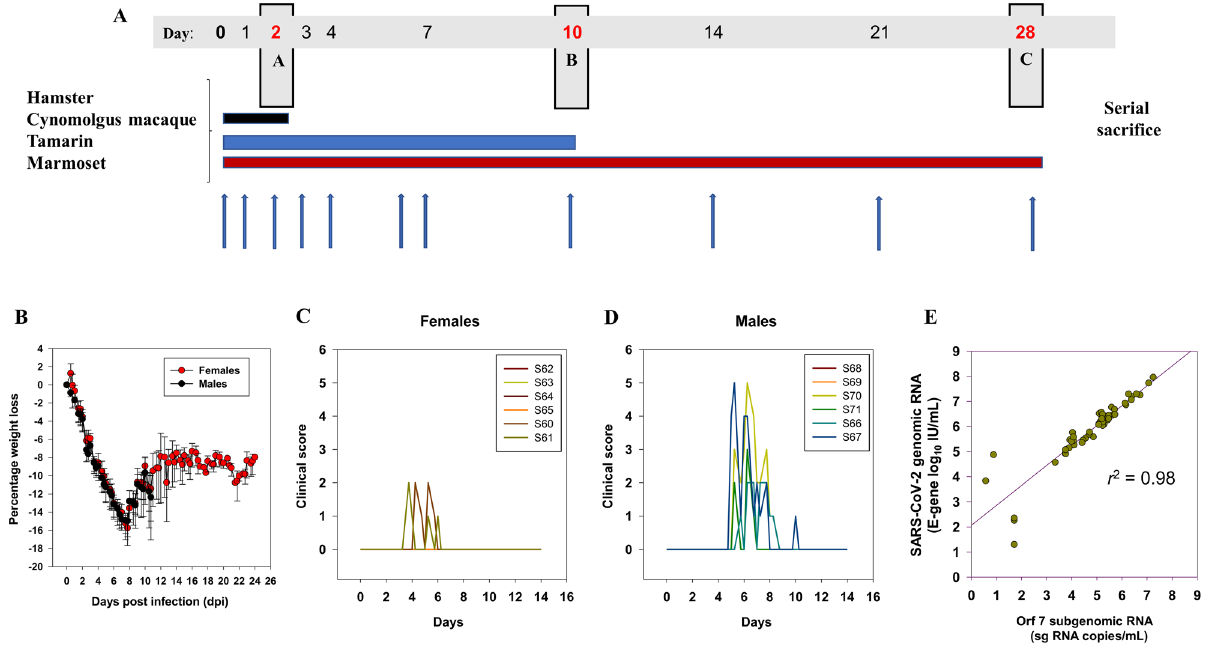
Figure 1. Study plan parameters. ( A ) Study outline for evaluation of SARS-CoV-2 in multiple species . Major termination time-points of A, B and C at 2, 10 and 28 days post-infection (dpi) respectively; vertical blue arrows indicate sampling frequencies. At termination, tissues taken for analysis were lung, trachea, oesophagus, olfactory bulb, tongue, tonsil, salivary gland LN, salivary gland, aorta, heart, kidney, liver, MLN, PLN-LN, spleen, rectum, small intestine, large intestine. ( B ) weight loss profiles in female and male hamsters as percentage weight change from baseline (day of challenge) over 28 days (females, red) and 11 days (males, black). SE bars indicated; ( C , D ) clinical score comparison between female and male hamsters respectively; ( E ) strong linear relationship between SARS-CoV-2 E-gene genomic RNA (gRNA) expressed as log 10 IU/mL against subgenomic (sg) Orf7 RNA levels expressed as log 10 copies/mL in 51 combined nasal and oral swabs over the first 10 days of Vic-01 tion and infectious virus microculture (Figs. 2, S5, S6). Additional faecal shedding data was collected for female hamsters and cynomolgus macaques (Figs. 2, S7). High levels of SARS-CoV-2 gRNA and sgRNA (range log 10 6–8 IU/mL gRNA, copies/mL sgRNA) detected in oropharyngeal or nasal swabs in female hamsters 2dpi had predominantly cleared 10dpi, (gRNA log 10 1–3 range), which remained undetectable with low, transient blips 21–28 dpi (S60, S61). The wide kinetic range of gRNA and sgRNA variation in intensively monitored naso- and oro-pharyngeal swabs in female hamsters was highly correlated during acute infection (Fig. 1E; correlation coefficient r 2 = 0.98, n = 51; Fig. S5A,B). Antigen (NP) was consistently detected 1–4 dpi in oropharyngeal swabs (Fig. 2B). Upper respiratory tract (URT) shedding patterns were broadly similar between genders at both sample sites. However loads peaked 2 dpi at significantly higher levels in male nasal swabs compared with female (mean log 10 7.16 vs 6.44 gRNA IU/mL, respectively (Mann–Whitney rank sum test, p = 0.013), though only weakly significant 4dpi (one-tailed t-test, p = 0.114). In oral swabs, mean gRNA levels 2 dpi were not statistically different between females and males (mean log 10 6.82 and 6.69 IU/mL respectively), though weakly statistically significant 4dpi (one-tailed t-test, p = 0.103). Infectious virus was only recovered between 1 and 4 dpi, oral swabs more frequently positive in both sexes; 7/20 (nasal) and 15/20 (oral) swabs in females compared with 16/20 (nasal) and 17/20 (oral) swabs in males (Figs. 2C,D, S6). Post- acute (10dpi) viral shedding was low/undetectable in female hamsters, sporadic re-bounds at later time-points (S60, S61, d21 oral; S60, d14; S61, d28, nasal). Swab RNA dynamics compare with faecal pellets with sustained gRNA (range log 10 3–6 IU/pellet), lower but quantifiable sgRNA (range log 10 2–5 copies/pellet) over the first 10 days (Fig. 2E,F). Infectious virus was never recovered onto VeroE6/TMPRSS2 cells from faecal pellets though hamster S61 displayed an altered sgRNA profile and more persisting signal beyond 7 dpi. Cynomolgus macaques exhibited the highest gRNA levels (range log 10 8–9 IU/mL) 2 dpi, in oral and nasal swabs (Fig. 2G,H), > tenfold higher in nasal swabs compared with contemporaneous oral swabs (log 10 8.23 vs 7.05 IU/mL), attaining statistical significance (Mann–Whitney test, p = 0.026). This differential relationship maintained 4 dpi (mean log 10 7.63 vs 5.82 IU/mL gRNA) co-incided with infectious virus recovery frequency 1–4 dpi. Differences in genomic RNA levels 10 dpi were log 10 5.28 and 2.32 IU/mL gRNA in nasal and oral swabs respectively, retaining statistical significance (p = 0.029, both). Macaques S44 and S45 both retained strong gRNA positivity 14 dpi (~ log 10 5–6 IU/mL), clearing 21 dpi with a small rebound in oral swabs 21 dpi. Antigen (NP) was frequently detected in nasal swabs, S44 remaining detectably antigen positive 28 dpi (Fig. 2G). Virus isola- tion was frequent 1-4 dpi from both nasal and oral swabs (20/20 and 16/20 respectively). As in hamsters, sgRNA levels were consistently ~ 1–2 logs lower than gRNA 2–4 dpi (Fig. S5C). Low, transient gRNA was detectable